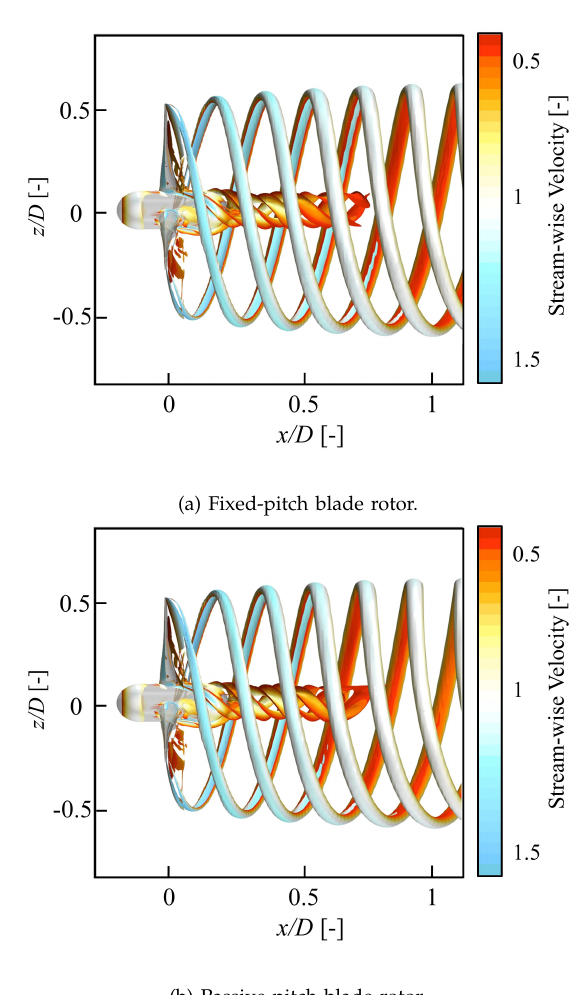
Fig. 11: Isosurfaces of nondimensional Q-Criterion, Q = 20 , colored by nondimensional streamwise velocity for the rotor equipped with (a) fixed and (b) passive pitch blades. The Q-criterion and the velocity are nondimensionalised using U hub and D .